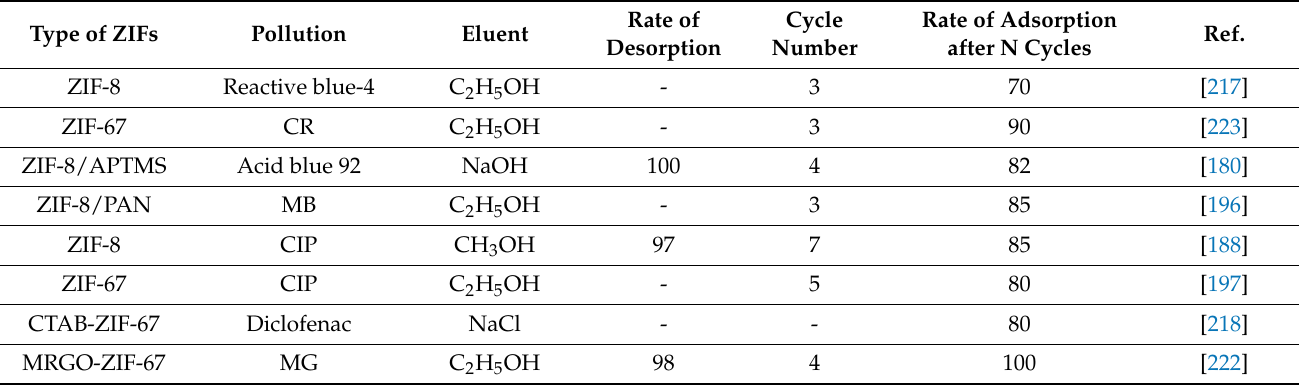
Table 4. Rate of desorption, adsorption of ZIF-8 and